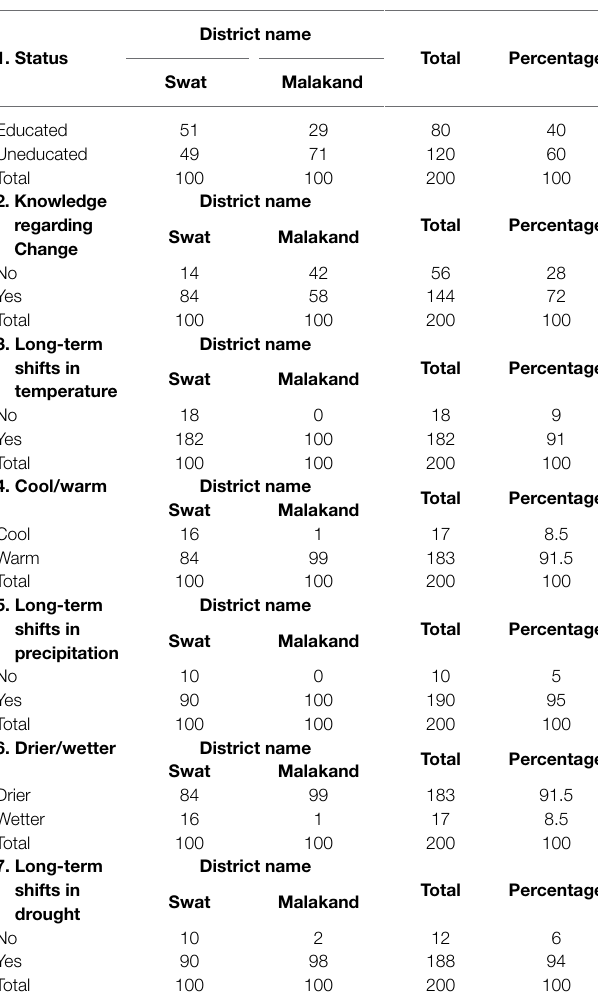
TABLE 1 | Impact of climate change on socioeconomic conditions of